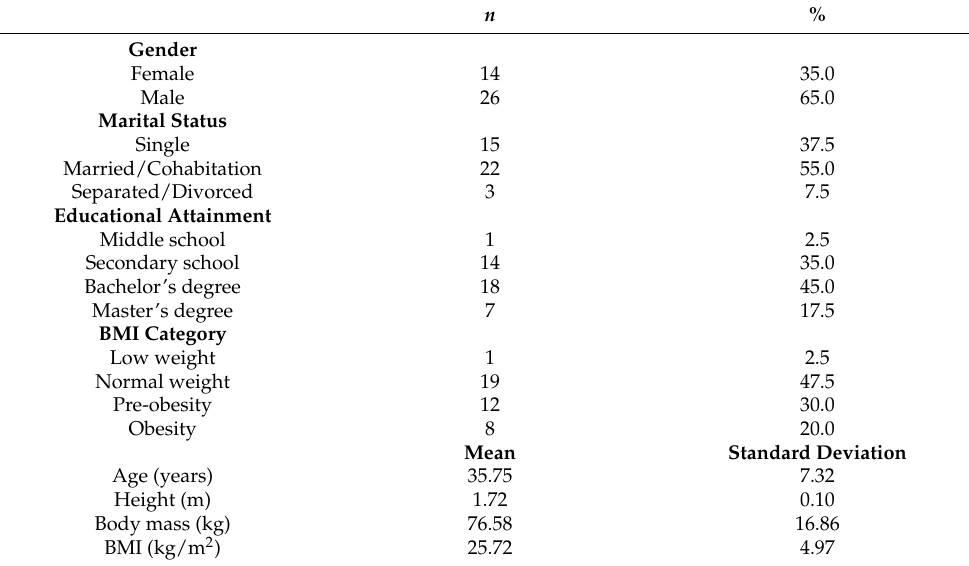
Table 1. Sample characteristics in M1 ( n =